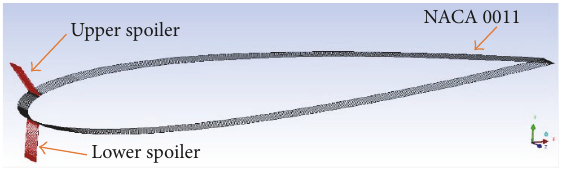
Figure 2: Simulated spoiler-ice shapes for NACA 0011.